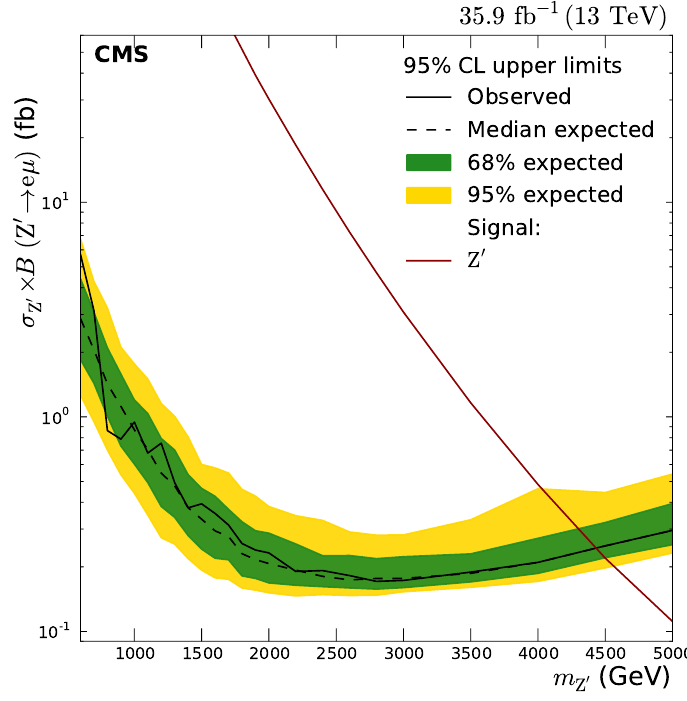
Figure 5 . The upper limits at 95% CL on the product of the signal cross section and the branching fraction, assuming B = 10% for the decay Z 0 ! e (cid:22) , as a function of m Z 0 . The 68 and 95% CL intervals on the median are indicated, respectively, by the inner green and outer yellow